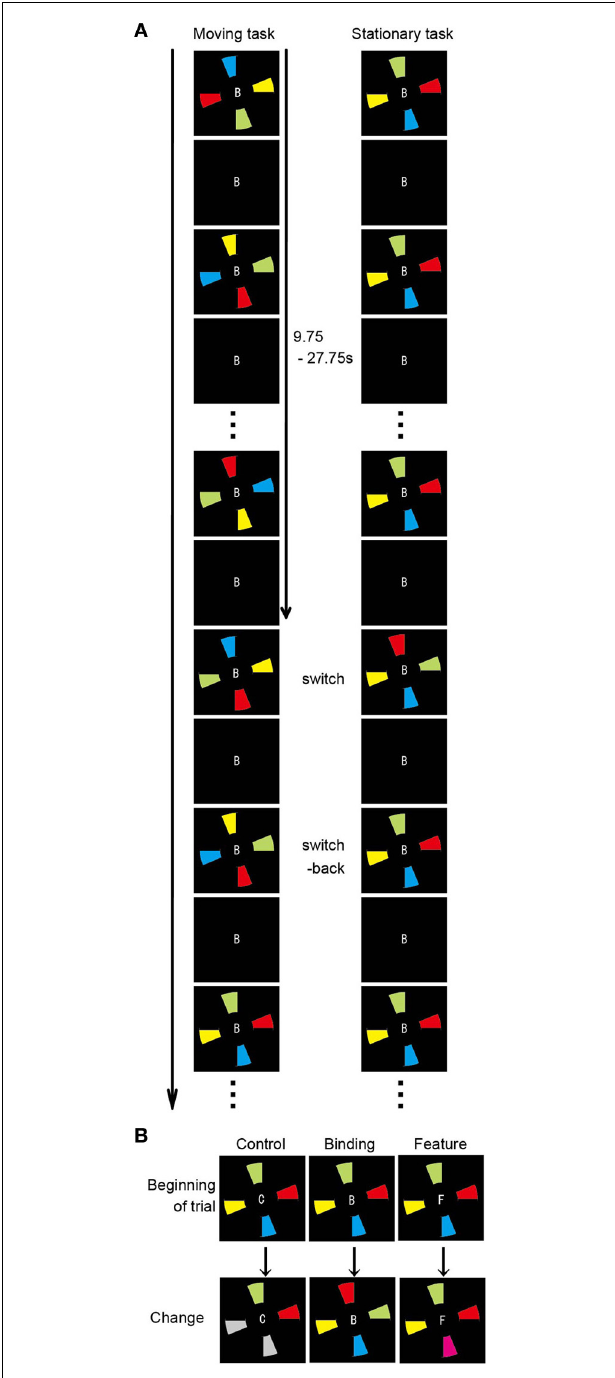
FIGURE 2 | Overview of the spatial updating task (Takahama et al., 2010). (A) Schematic diagram of the moving and stationary MOPT tasks. At the beginning of each trial, the occluder and the capitalized letter (B, F, or C) at the center of the visual stimuli are presented for 500ms. Then, the colored pies (moving task) or the occluder (stationary task) begins to rotate clockwise or anticlockwise. (B) Types of target change. In the control condition, 2 of the 4 colored targets turn gray. In the binding condition, the colors are switched for 2 of the 4 targets. In the feature condition, 1 of the 4 colored targets changes to a novel